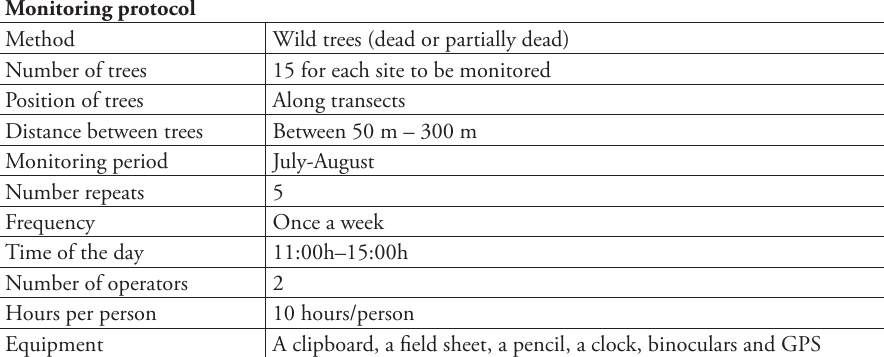
Table 9. Summary of the monitoring protocol for R. alpina